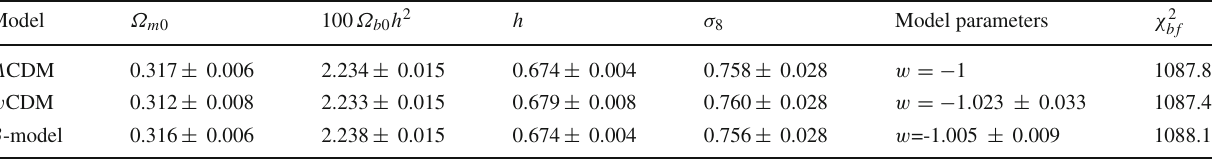
Table 1 A summary of best-fit values of the main cosmological parameters from MCMC chains. The χ 2 MCMC chains of each individual model